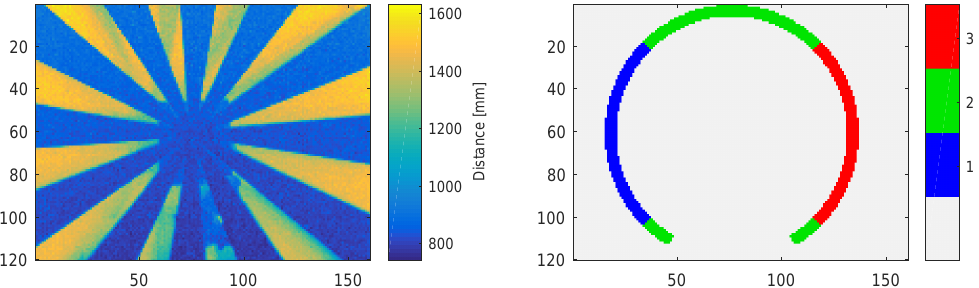
Figure 9. Turning Siemens star depth data example (left) and segments used in the evaluation